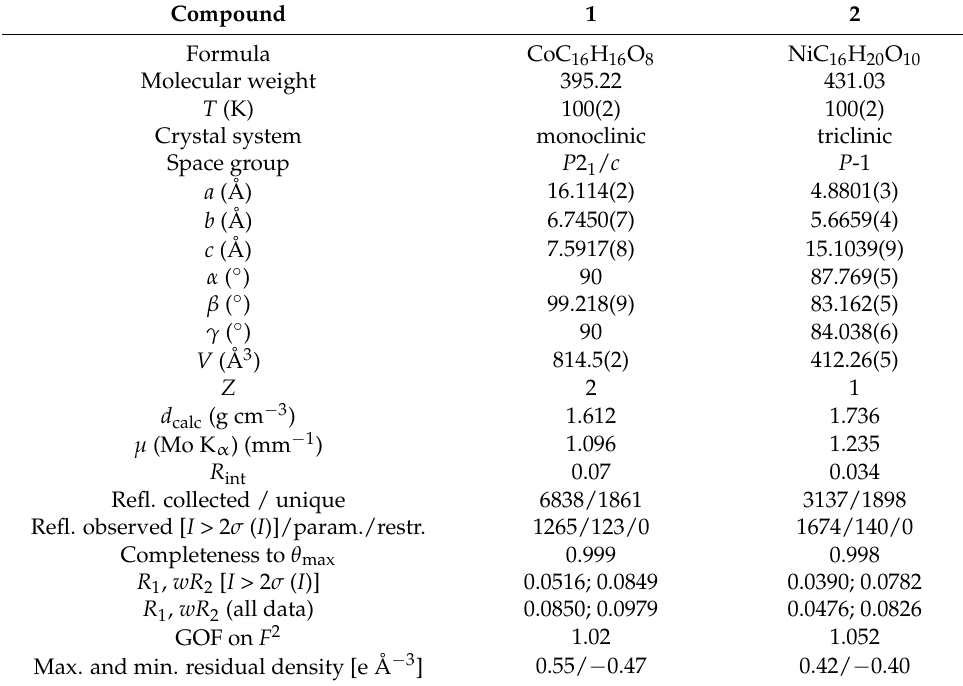
Table 1. Crystallographic data and refinement details for compounds 1 and 2